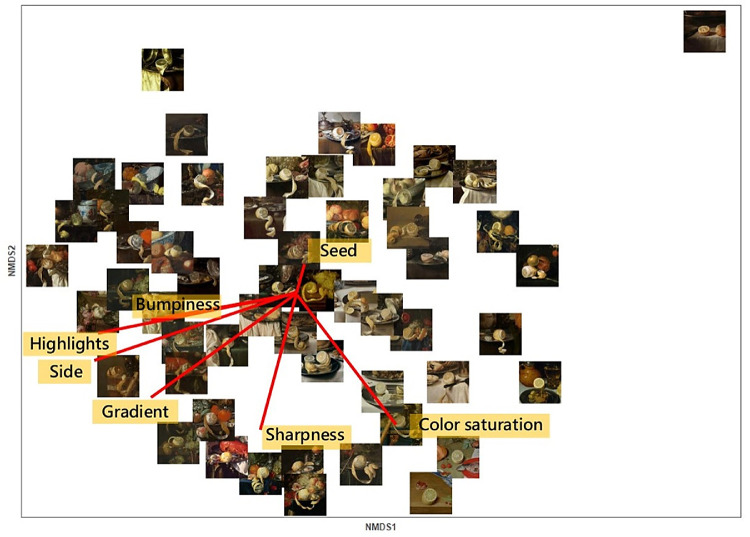
2D space of translucency perception with the stimuli shown at the corresponding coordinates. The red lines represent the vectors of the image features fitted in the space.